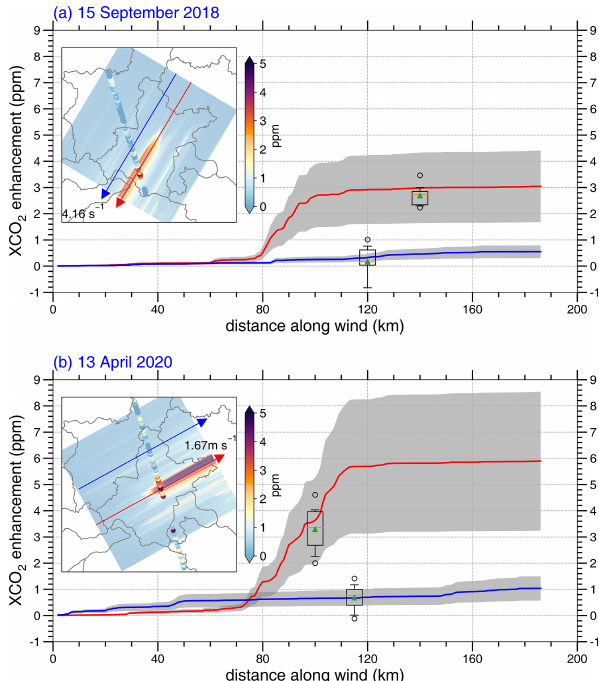
Figure 5. Two presentative predicted X CO 2 enhancement lines (red and blue) with uncertainty (grey shades) on (a) 15 Septem- ber 2018 and (b) 13 April 2020. When the X CO 2 enhancement lines pass through the OCO-2 orbit, the observed X CO 2 enhance- ments are shown with box plots. The mean values are shown as green triangles, and the outliers beyond the 5%–95% interval are shown as circles. The predicted X CO 2 enhancement line density maps overlaid with OCO-2 observed X CO 2 enhancement on each day are shown inside, with the position of the presentative lines and the wind